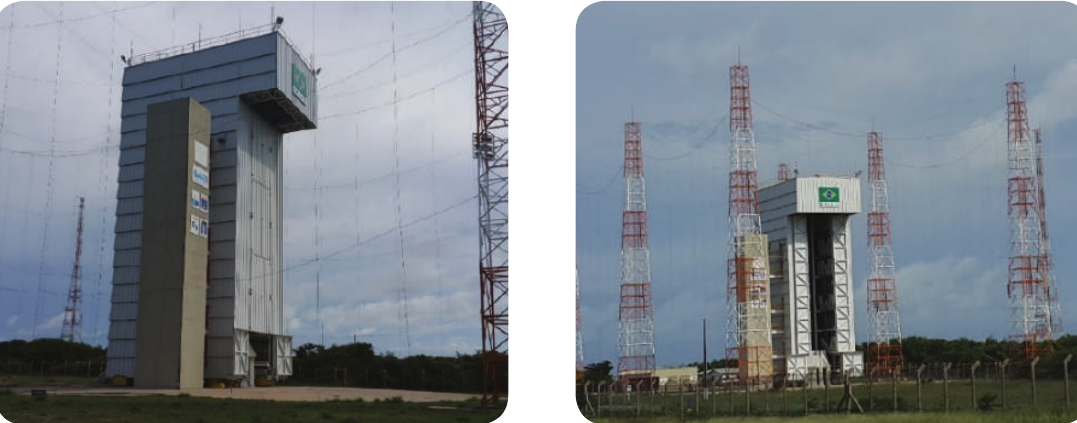
Figure 2. Launch Pad Area (LPA).